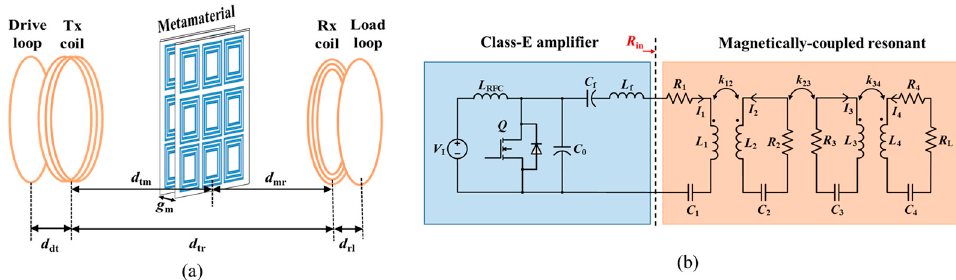
Figure 1. ( a ) Schematic diagram of a wireless power transfer (WPT) system with metamaterials (MMs). ( b ) The equivalent circuit diagram of a four-coil WPT system.